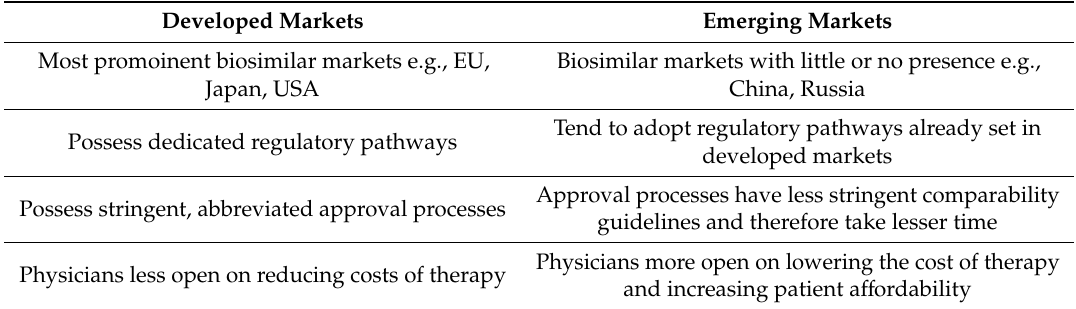
Table 7. Categorization and comparison between global biosimilar